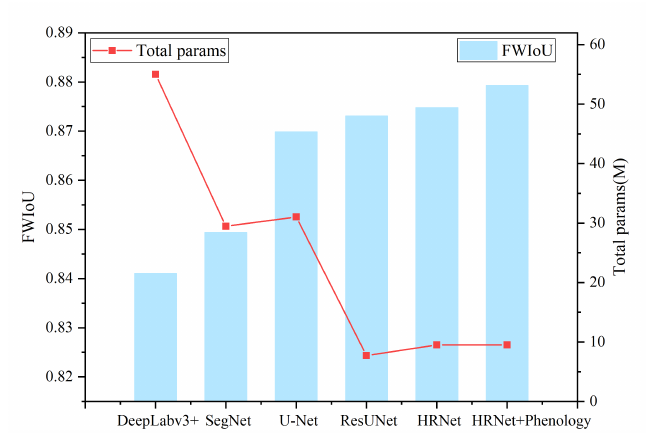
Figure 6. Comparison of Frequency Weighted Intersection over Union (FWIoU) and total parameters of different networks. The bar represents FWIoU evaluated on the Beijing Olympic Park dataset, and the broken line represents the total parameters of different networks (M).